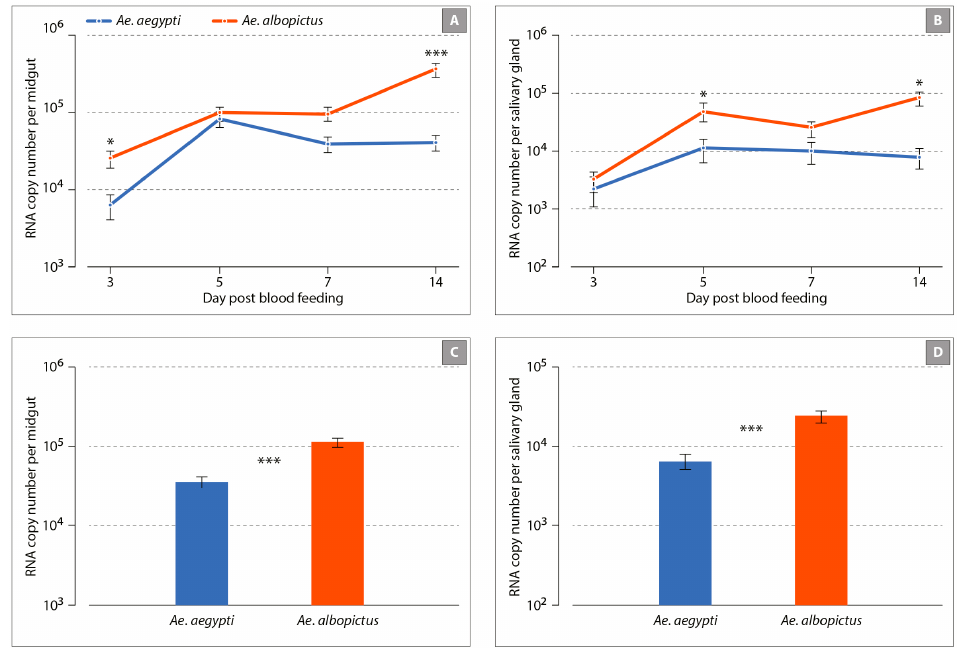
Figure 1. Viral infection rates after oral exposure to Aedes aegypti and Aedes albopictus. Panels ( A , B ) represent the rate of viral infection across time in the midgut and salivary glands, respectively. Error bars represent the 95% confidence interval.